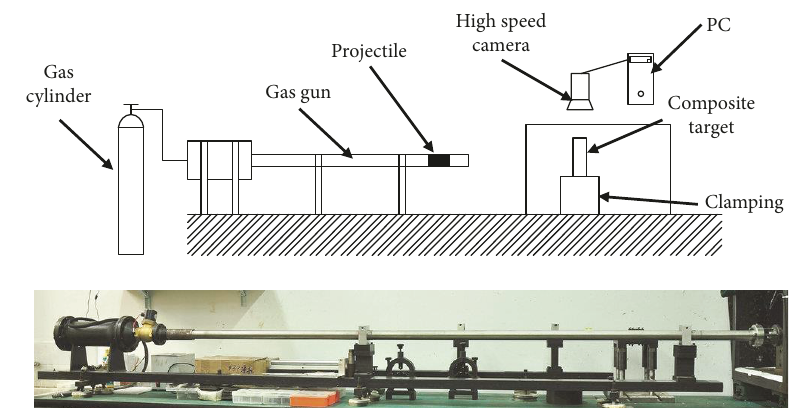
Figure 1: Gas gun testing system.